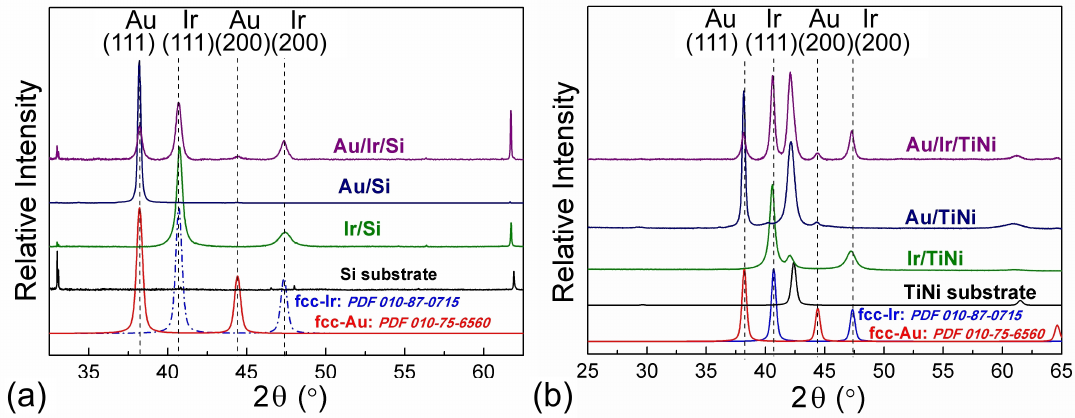
Figure 4 Figure 4. Diffraction patterns of Ir, Au, and Au/Ir samples deposited in the same MOCVD experiments on ( a ) Si; ( b ) TiNi. [(CH 3 ) 2 Au(thd)] was chosen as a volatile precursor for subsequent deposition of discrete gold film [46]. In the same experiment, Si and TiNi wafers were used as substrates as well as Ir/Si and Ir/TiNi samples described above. The results of studying the obtained samples (Au/Si, Au/TiNi, Au/Ir/Si, and Au/Ir/TiNi) using XRD and SEM are shown in Figures 4 and